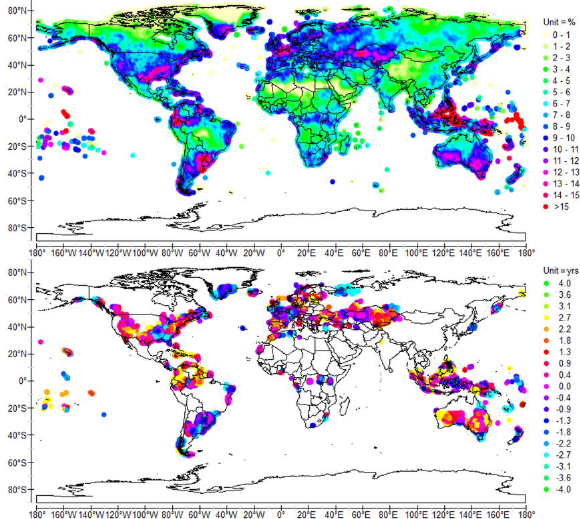
Figure 6. Cross-wavelet power ( top ) and coherence phase ( bottom ) of reduced rainfall height, scale-averaged over the 5 – 10-year band, time-averaged over 1901 – 2009. – SOI (the opposite of the southern oscillation index beginning January 1866, provided by the National Centre for Atmospheric Research [32]) is used as the temporal reference [22]. The reduced rainfall height is the rainfall height divided by its mean value [29]. The wavelet power spectrum is normalized by the total variance, so it represents the percentage of variance explained in the stated bandwidth (5 – 10-year band). The Cross-Wavelet and the Complex Empirical Orthogonal Function (EOF) analyses have similarities, the latter being more familiar to marine scientists and climatologists. However, if the two methods are similar for typical frequency domain analyses, that is, the power spectral and coherency analyses, they are far different in terms of the time domain. In complex EOF analysis, the time lag between time series is basically the computation of eigenvector and eigenvalue of a covariance or a correlation matrix computed from a group of original time series data. In contrast, the cross-wavelet analysis is well suited to highlight the time lag between time series when it varies continuously (here, the reduced rainfall height and – SOI used as the time reference). Rainfall height data are provided by the NOAA (National Oceanic and Atmospheric Administration). ftp://ftp.cpc.ncep.noaa.gov/precip/cmap/monthly/.